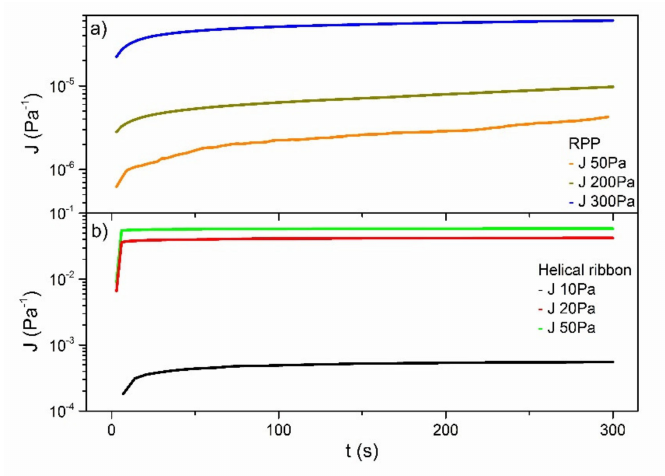
Figure 3. Compliance modulus evolution with time for M200 sample under different applied stresses using ( a ) rough plate-plate geometry and ( b ) helical ribbon geometry.